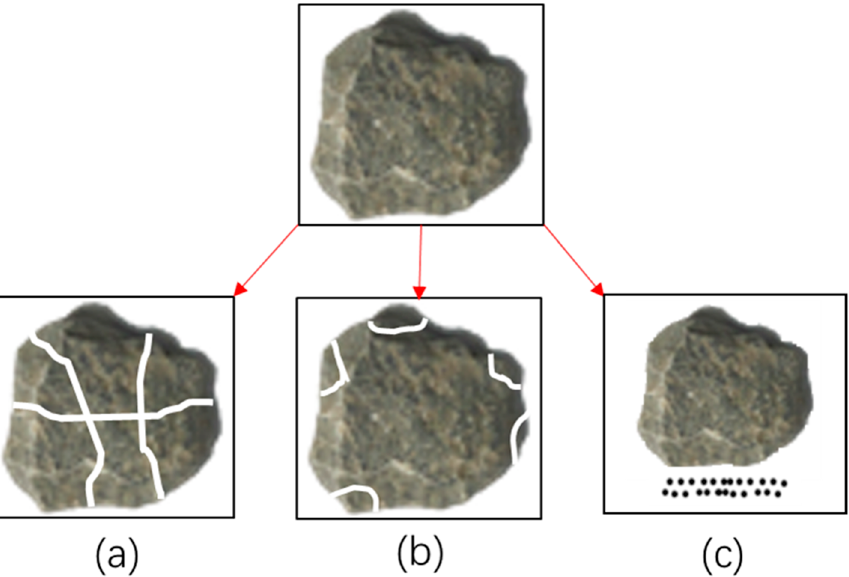
Figure 4. Schematic diagram of aggregate breakage modes (( a ): fracture mode; ( b ): attrition mode; ( c ): abrasion mode).